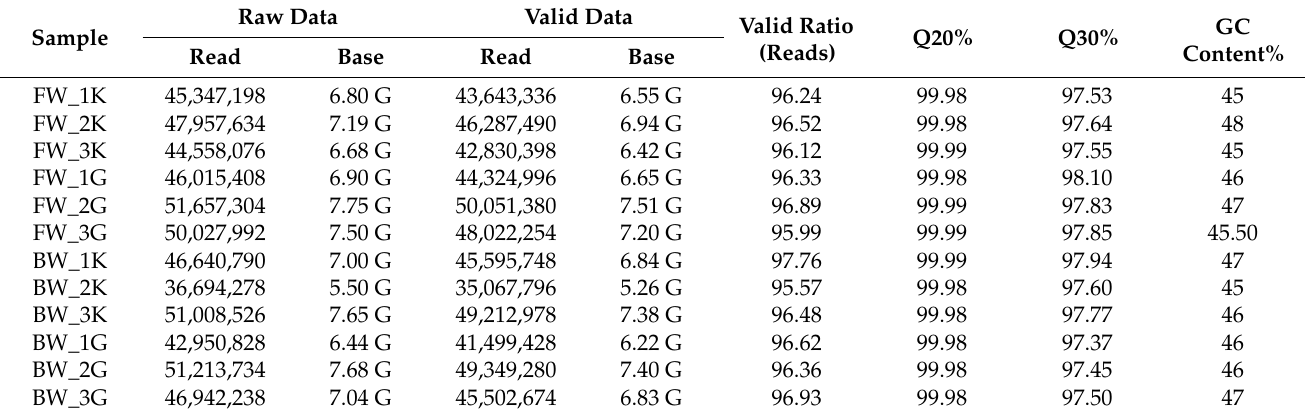
Table 1. Overview of sequencing results of freshwater and brackish water groups.